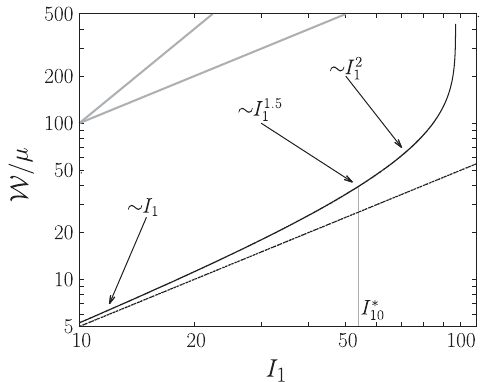
FIG. 6. Strain energy density function given by the incompress- μ J ible Gent material model W ¼ − 1 log f 1 − ½ð I 1 − 3 Þ =J 2 m m (cid:3)g 97 , plotted in log-log scales (black solid line). [21], with J m ¼ 3 is the limiting value of the first invariant I Note that J 1 . The m þ strain energy density function for the neo-Hookean material is plotted with a dashed line. The two gray straight lines indicate slopes 1 and 2, i.e., values of the local exponent α 1 equal to 1 and 2. Here, I (cid:4) 10 is the value of the first invariant beyond which the local exponent is larger than 3 = 2